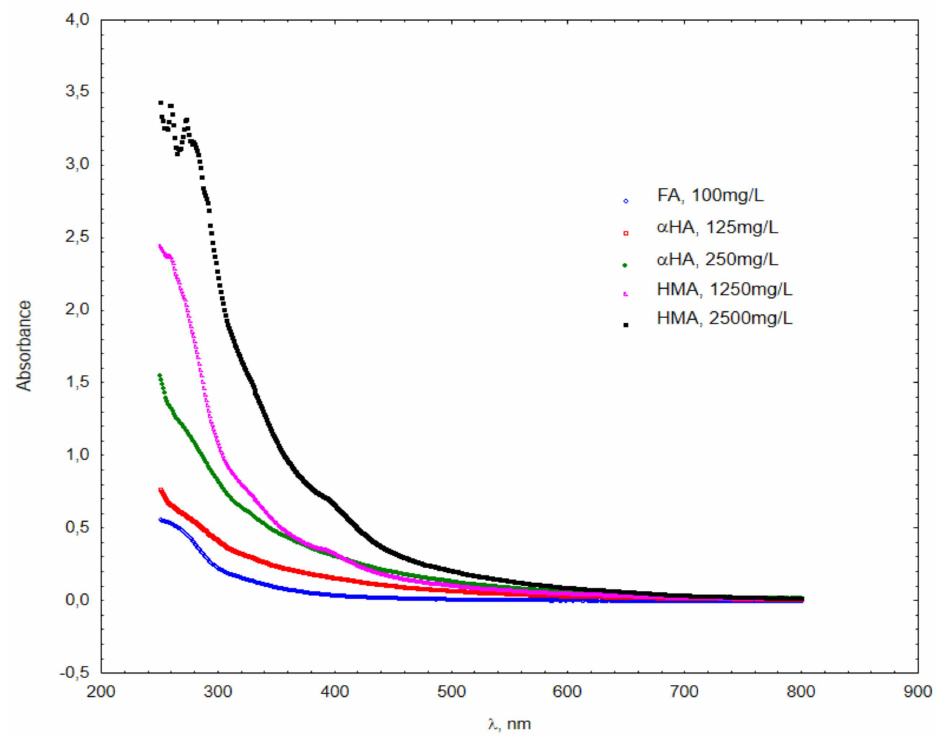
Figure 3. UV-VIS spectra of humus acids extracted from digested sludge of the Płasz ó w wastewater treatment plant.